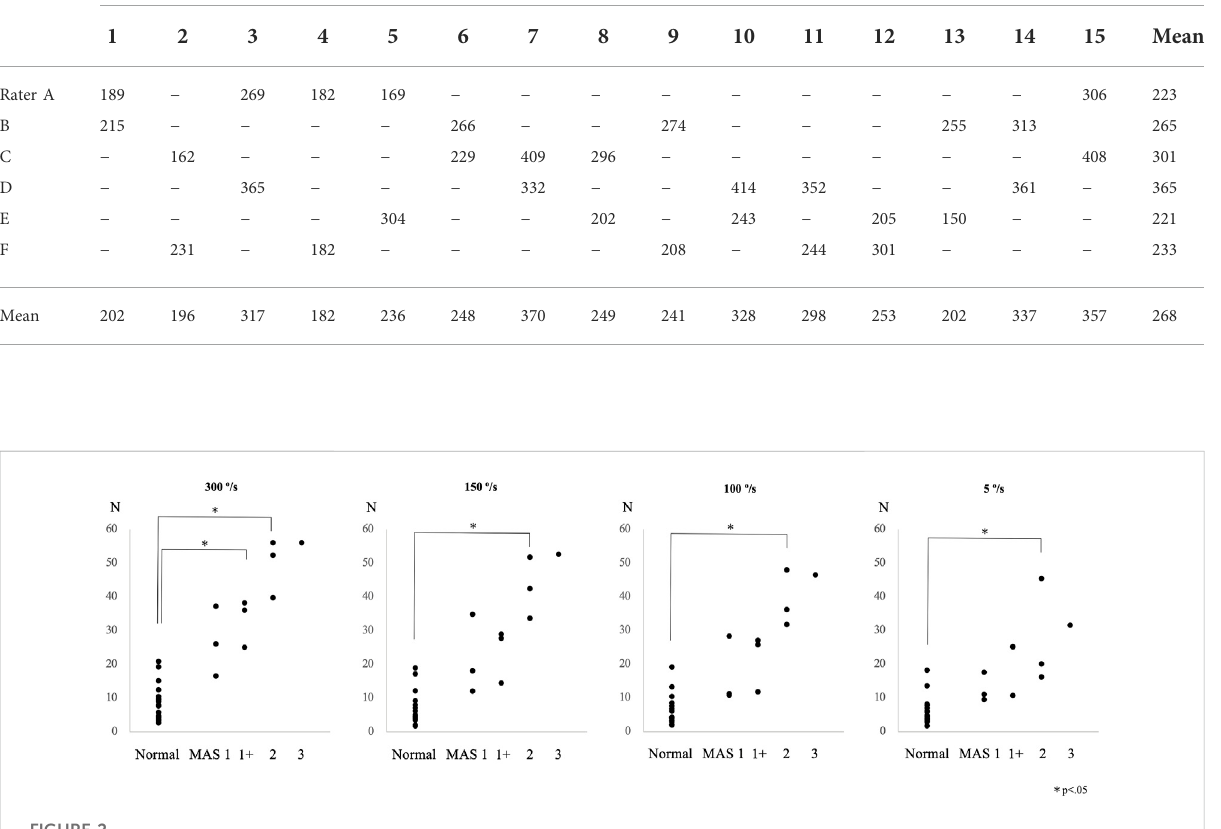
FIGURE 2 Peak resistance force values at angular velocities of 300 ° /s, 150 ° /s, 100 ° /s, and 5 ° /s are shown for the control and the patient subgroups, classi fi ed according to the Modi fi ed Ashworth Scale (MAS) score in Experiment